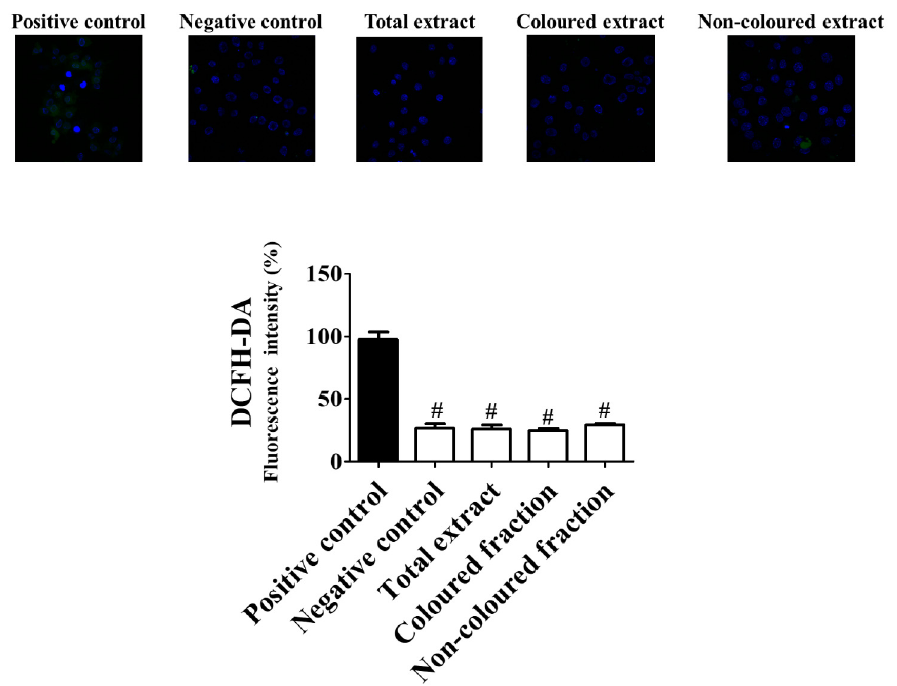
Figure 6. Protective effects of sweet cherry extracts (100 µg/mL) after 24 h of treatment against reactive oxygen species production in HepG2 cells. HepG2 cells were pre-incubated with 2,7-dihydrodichlorofluorescein diacetate (DCFH-DA) (5 µM, 15 min). Control cells were incubated with Dulbecco’s modified Eagle’s medium plus vehicle (negative control) and with 10 mM H 2 O 2 for 20 min (positive control). All cells were stained with 2,7-dihydrodichlorofluorescein diacetate (DCFH-DA). Results are expressed as mean ± SEM of five independent assays, performed in triplicate ( # p < 0.0001 compared to the respective positive control). Representative images of HepG2 cells were taken by confocal microscopy.